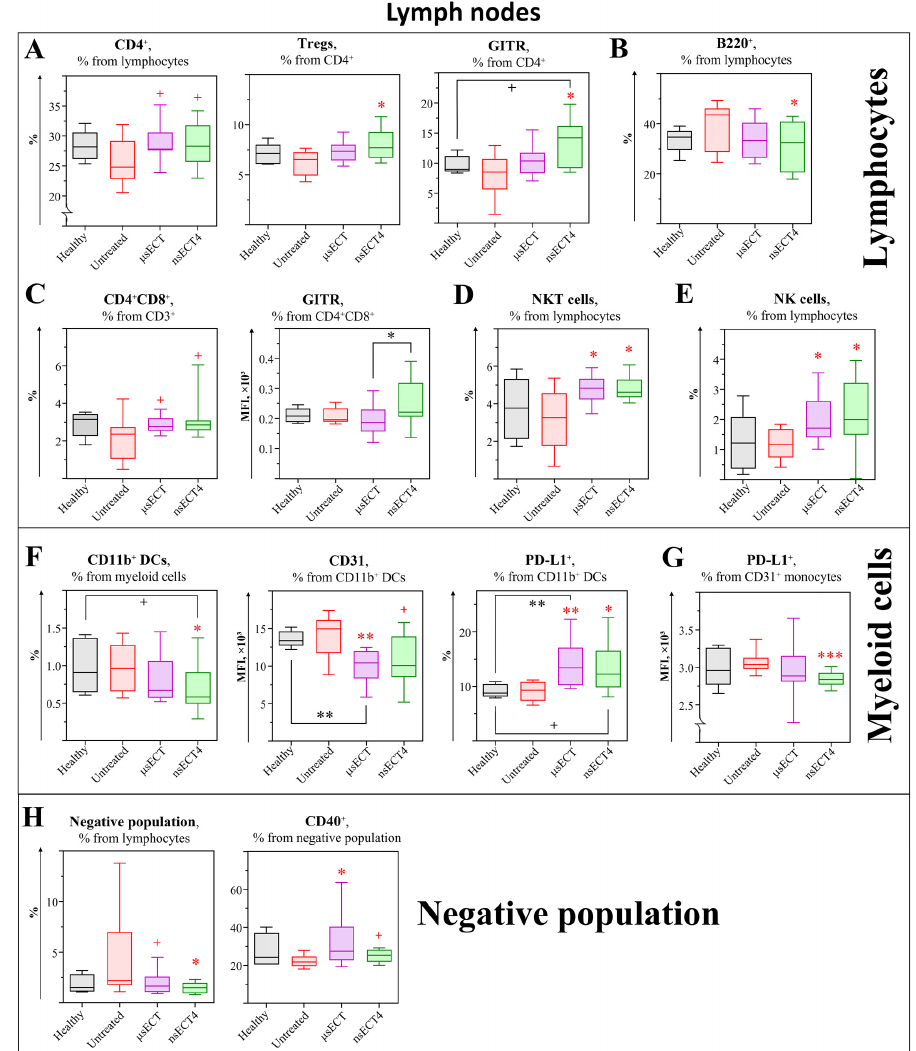
Figure 7. Time-independent study. Lymphocytes ( A – E ), myeloid cells ( F , G ) and “Negative” (Lin − ) population ( H ) in murine lymph nodes. Cytometry was performed with BD FACSAria III cytometer. Statistically significant (* p < 0.05; ** p < 0.005; *** p < 0.0005) differences and tendencies (+ p = 0.05–0.1) compared to the untreated